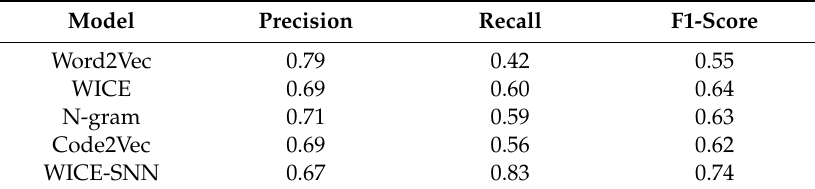
Table 1. Results on Dataset1.